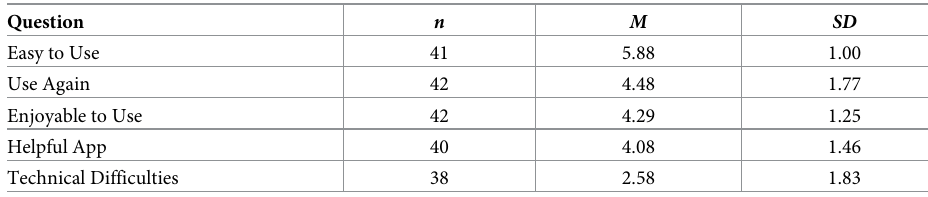
Table 3. Mean and SD for feedback about app